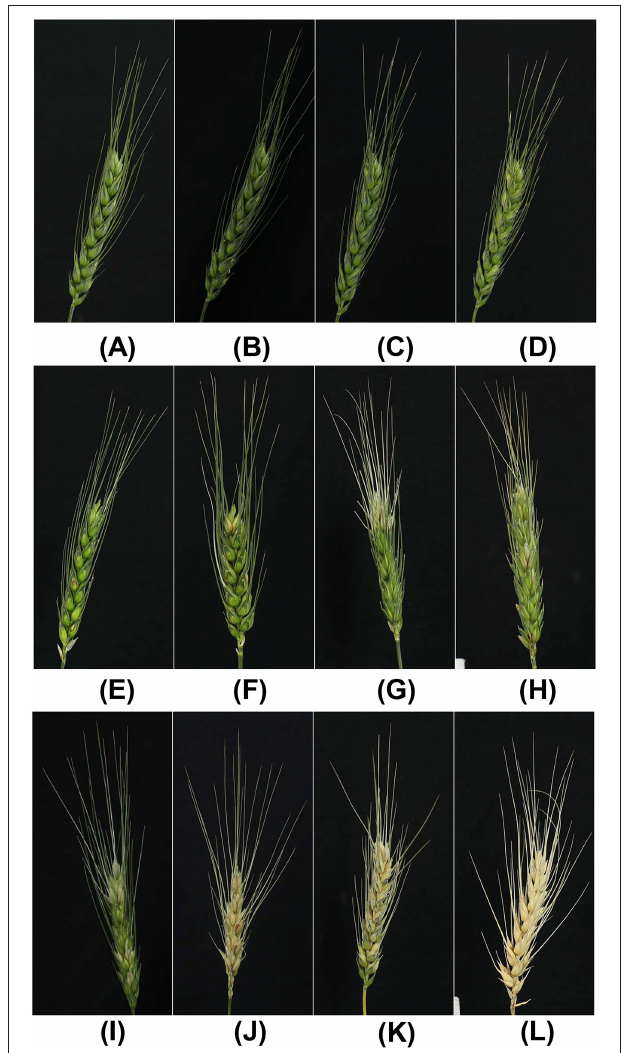
FIGURE 2 | Examples of images per category: (A–D) healthy wheat spikes no disease (0% severity, Category 1); (E–H) spikes with moderate severity (0.1–20%, Category 2); and (I–L) spikes with high severity (20.1–100%, Category